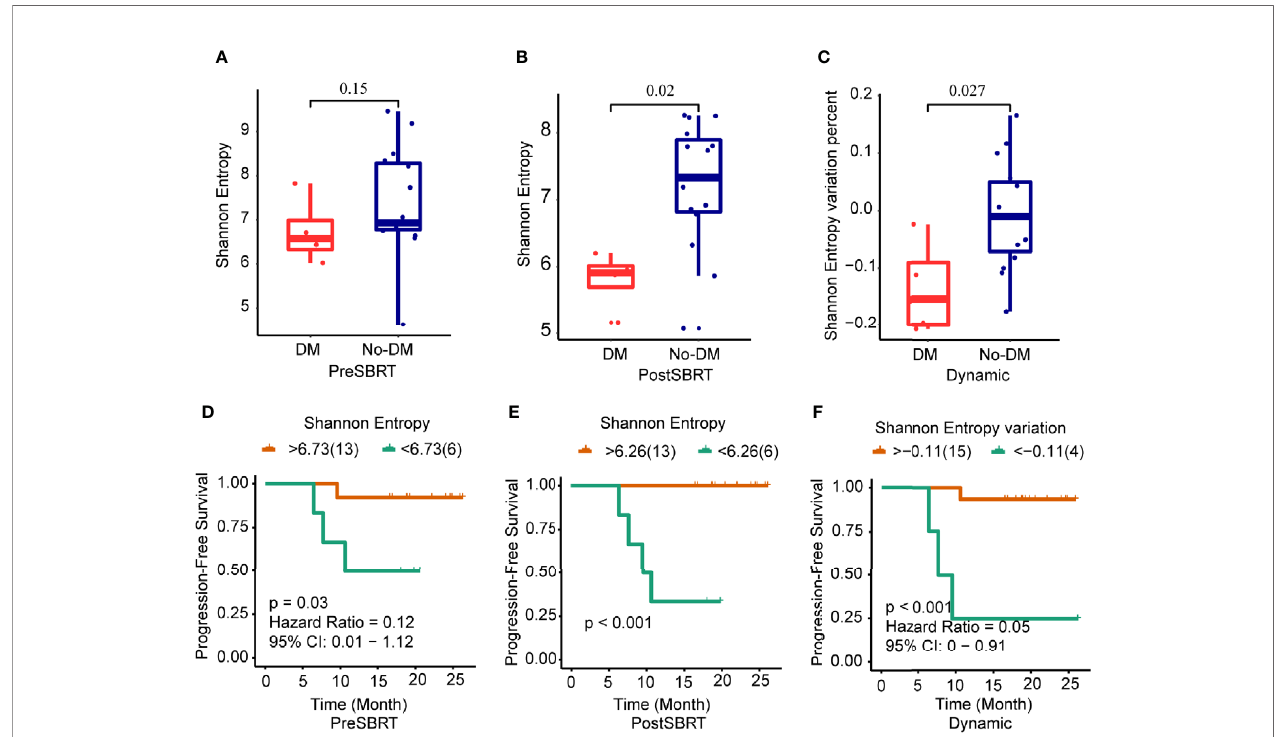
FIGURE 2 | Changes in Shannon Entropy and treatment outcomes after SBRT. (A − C) Boxplots showing differences in Shannon Entropyes in baseline (before- SBRT) samples (A) ; in samples collected after SBRT (B) ; and in the difference in Shannon Entropy between before and after SBRT [Shannon Entropy after SBRT minus Shannon Entropy before SBRT)/(Shannon Entropy before SBRT)], according to whether patients developed metastases after SBRT (DM) or did not (no-DM). (D − F) Kaplan – Meier progression-free survival estimates according to Shannon Entropy cut-off levels for samples obtained before SBRT (D) , after SBRT (E) , or the percent change in Shannon Entropy from before to after SBRT (F) . Patients with high baseline Shannon Entropy (i.e., >6.73) had signi fi cantly longer progression-free survival; patients with high post-SBRT Shannon Entropy (>6.26) had longer progression-free survival; and patients with higher percent change in Shannon Entropy (> − 0.11) had longer progression-free survival. P values are derived from unadjusted log-rank